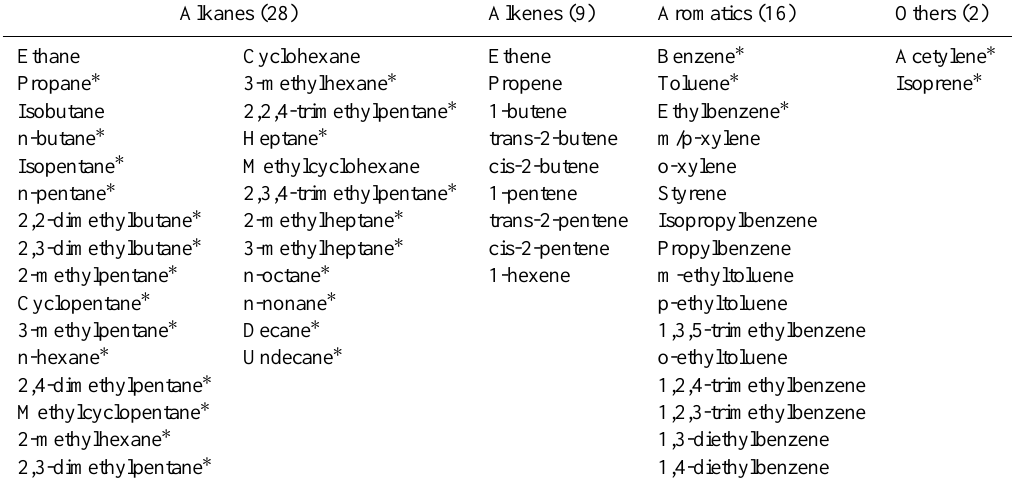
Table 2. The NMHCs quantified in this study. Alkanes (28) Alkenes (9) Aromatics (16) Others